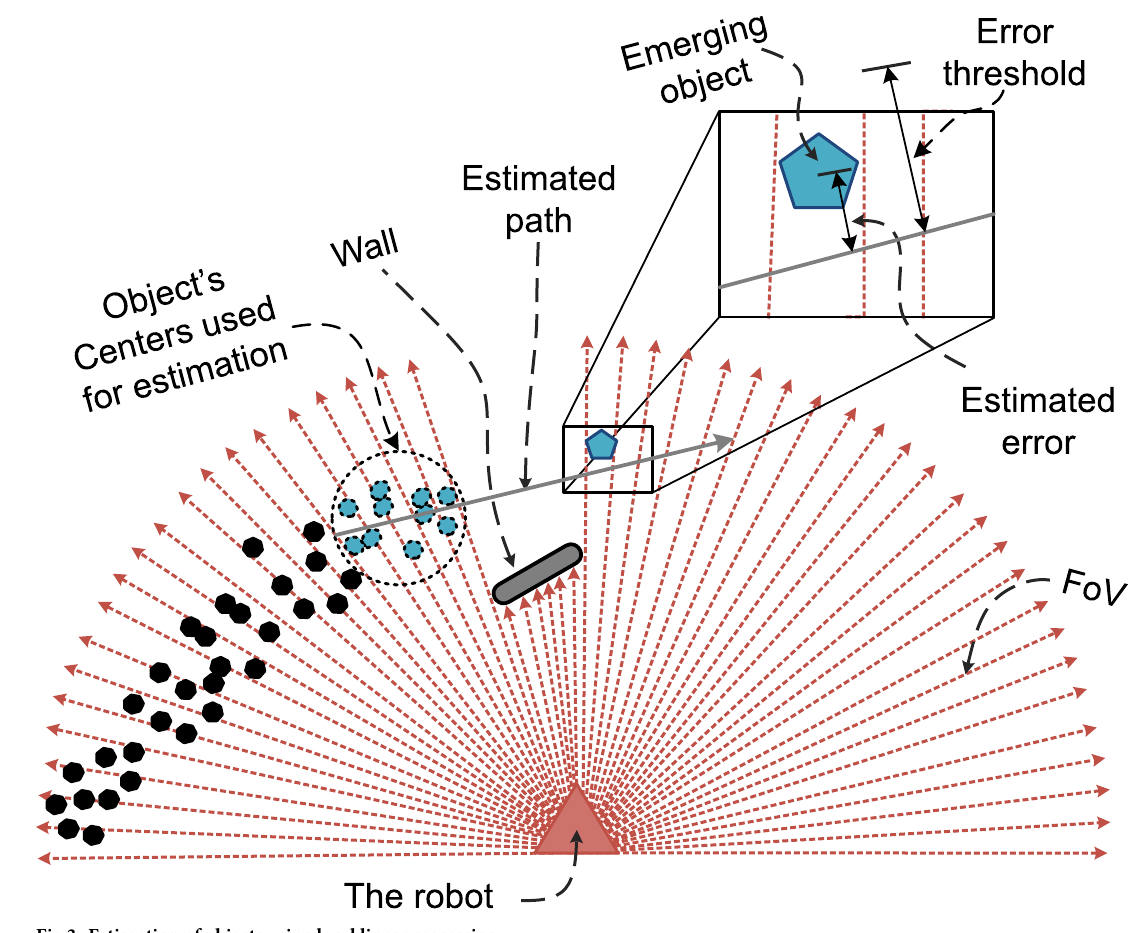
Fig 3. Estimation of objects using local linear